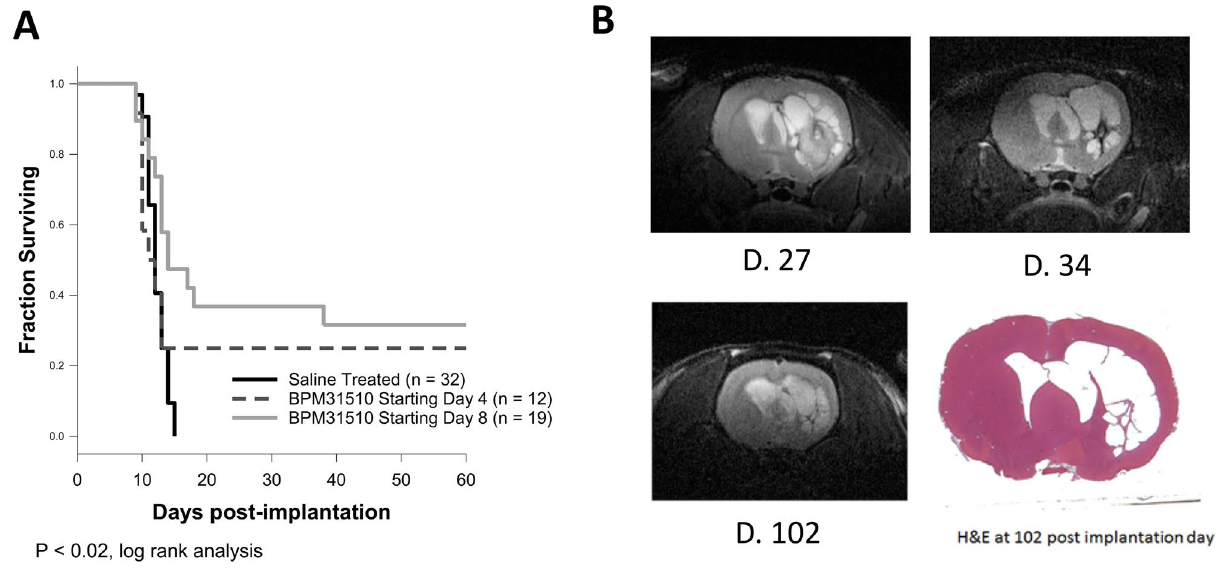
Figure 6. Ubidecarenone demonstrates efficacy in an orthotopic glioma model. Wistar rats received either saline or 50 mg/kg BPM31510 IP, twice daily, five days per week, starting at either 4 (n = 12) or 8 (n = 19) days after implantation of 10 6 C6 glioma cells into the right striatum. ( A ) Survival of rats treated either with saline (n = 32) or BPM31510. Over 25% of BPM31510 treated rats survived to the end of experiment (at least 75 days) compared to 0% of PBS treated controls (P < 0.01, log rank statistic). No significant difference was noted between the BPM31510 treated groups starting at 4- or 8-days. ( B ) Serial MRI of a long-term survivor (Day 27, Day 34, and Day 102 post-implantation) demonstrating persistent effects even after treatment was withdrawn.